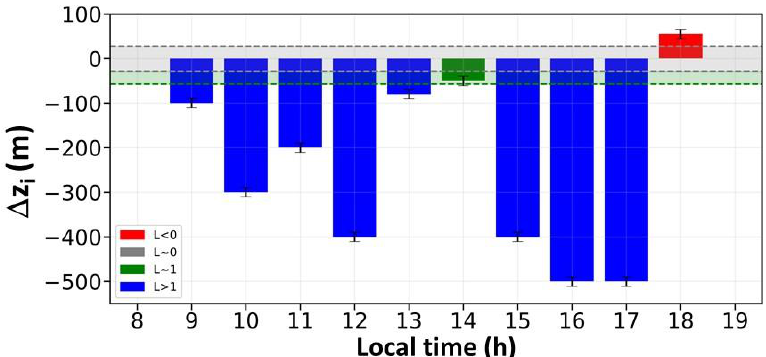
Figure 6. Diurnal evolution of ∆ z i and L on 8 August 2019. Gray and green shadows represent the regions where L tends to 0 and 1, respectively.